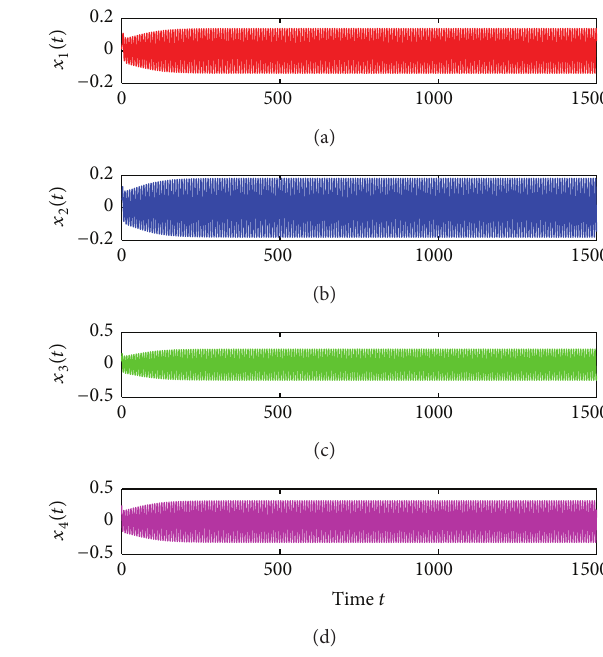
Figure 11: The trajectory of 𝑥 1 , 𝑥 2 , 𝑥 3 , and 𝑥 4 when 𝜏 = 0.85 > 0.7915 = 𝜏